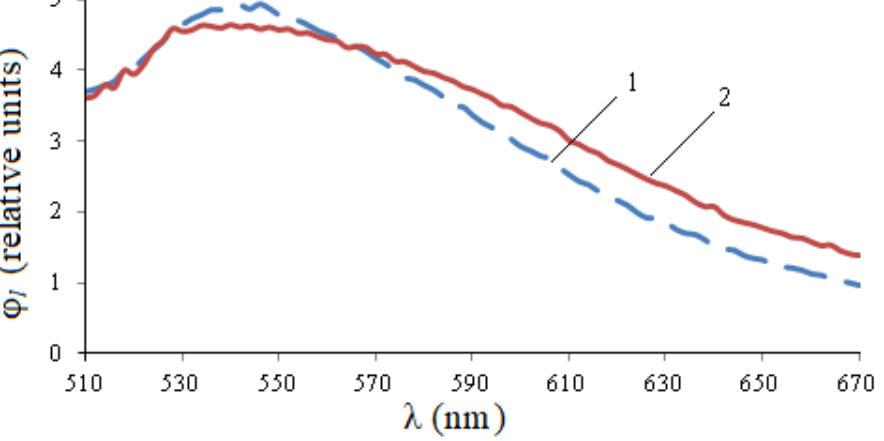
Figure 6. Spectral characteristics of luminescence of wheat seeds at λ e , 4 = 485 nm: 1 — not infected, 2 — 98% infected.